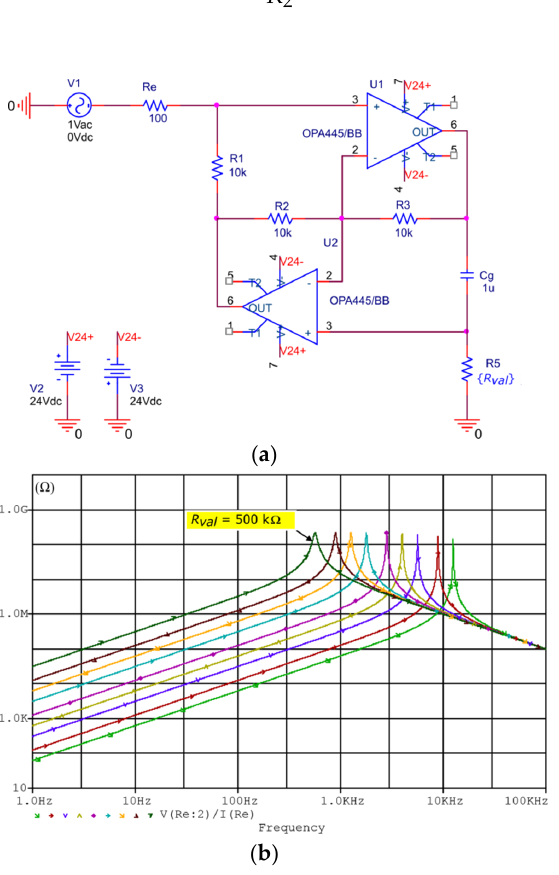
Figure 2. Synthetic inductor: ( a ) Antoniou gyrator implemented with an OPA445 Op-Amp. ( b ) Impedance simulation results for R val = {500 kΩ, 200 kΩ, 100 kΩ, 50 kΩ, 20 kΩ, 10 kΩ, 5 kΩ, 2 kΩ, 1